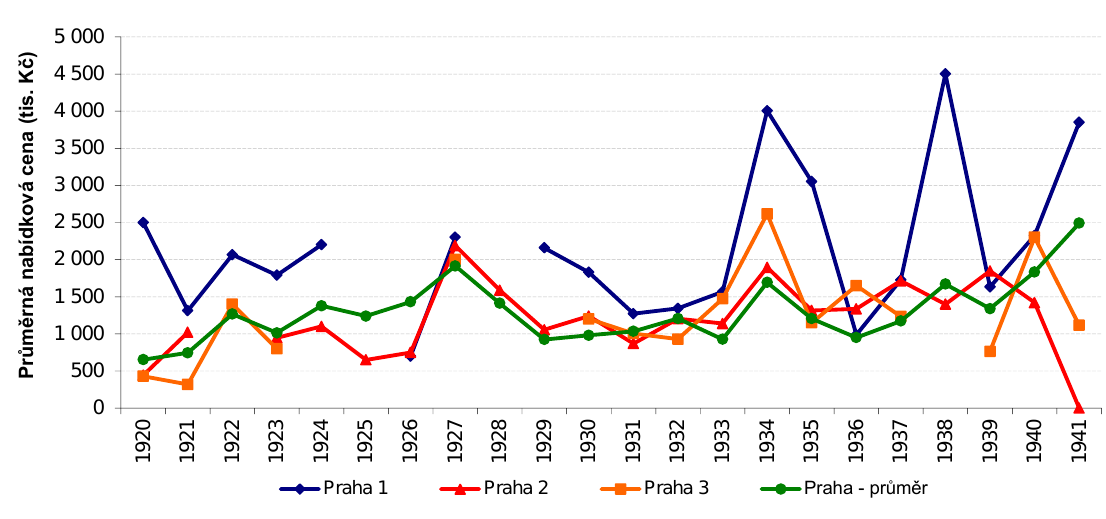
Obrázek 13: Průměrná nabídková cena bytového domu v Praze 1, 2, 3 a průměr za Prahu jako